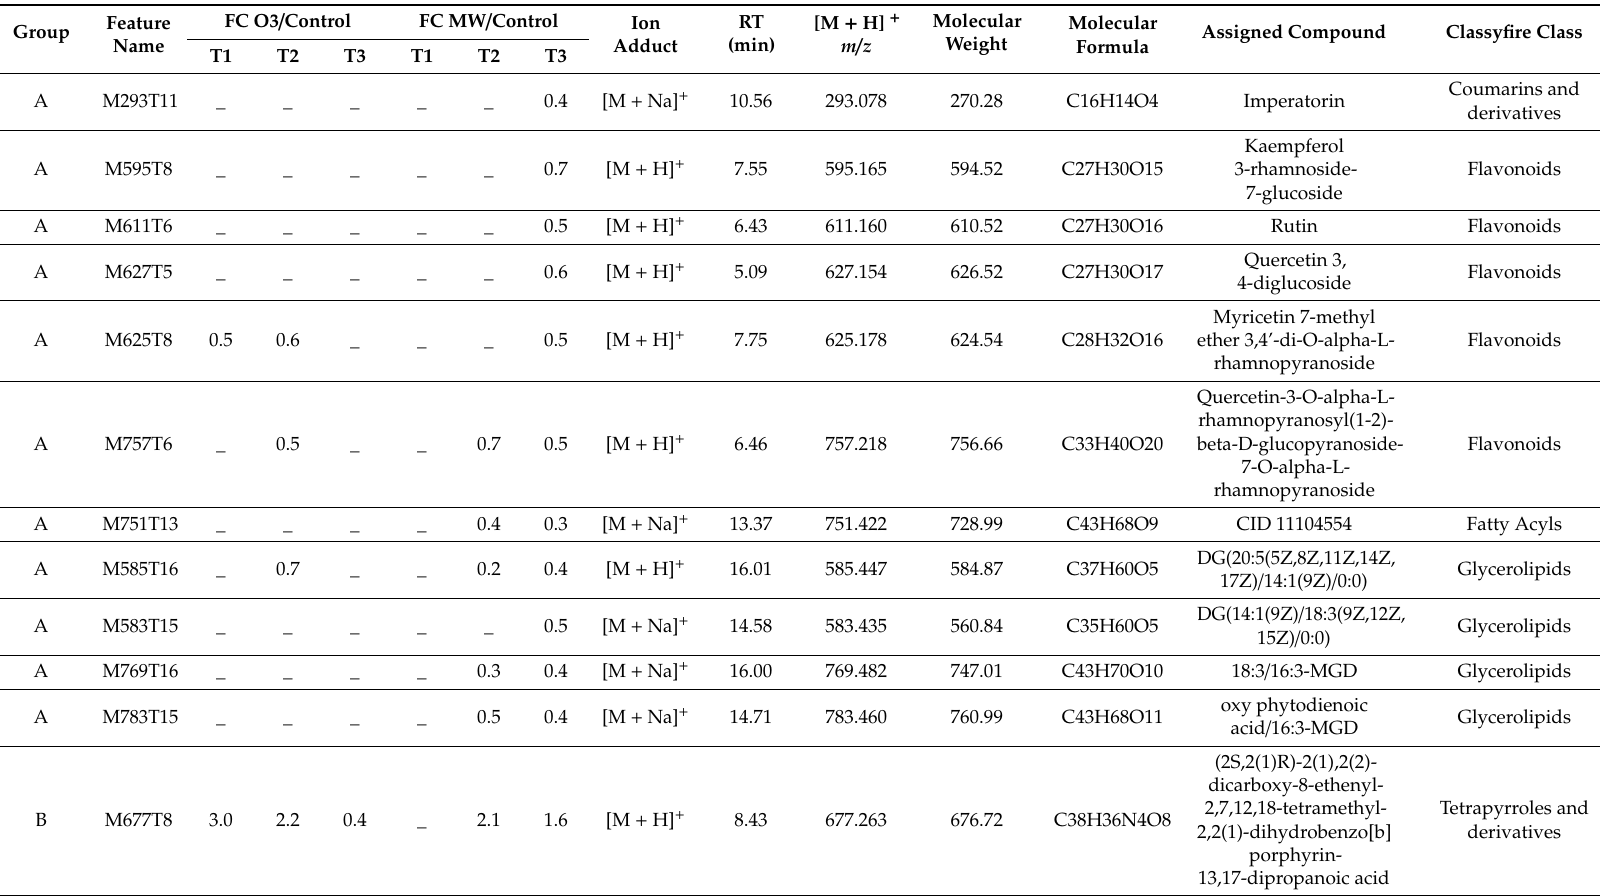
Table 2. Identification of the DAMFs. The identified DAMFs are listed and categorized into three groups (A, B, C). Group A contains DAMFs negatively a ff ected by O 3 , MW, or both; Group B contains DAMFs over accumulated under O 3 (250 ppb) and MW treatment; Group C contains DAMFs over accumulated only under MW treatment. For each DAMF, the fold change (FC) of the treatment / control is given only when significant ( p <